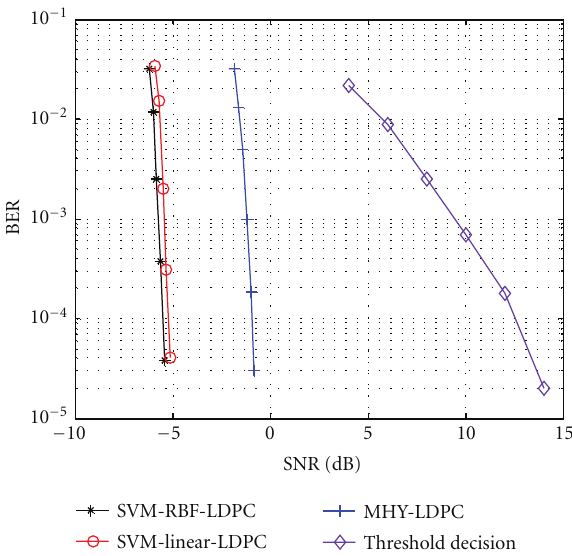
Figure 9: Performance at the output of the LDPC decoder with the soft-input and threshold decision.